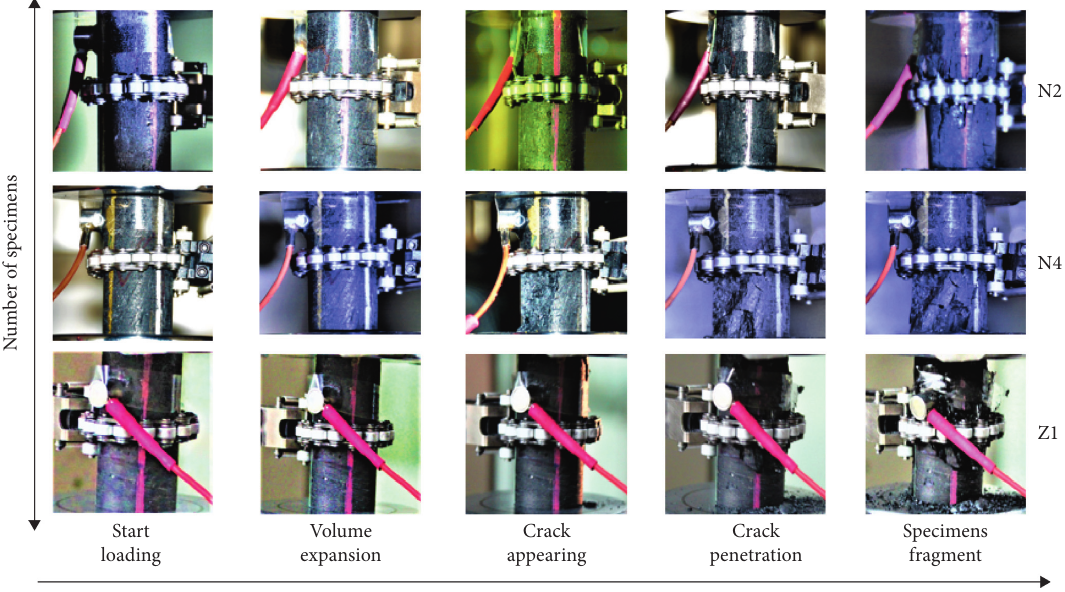
Figure 5: Typical static compression crack initiation and propagation characteristics.